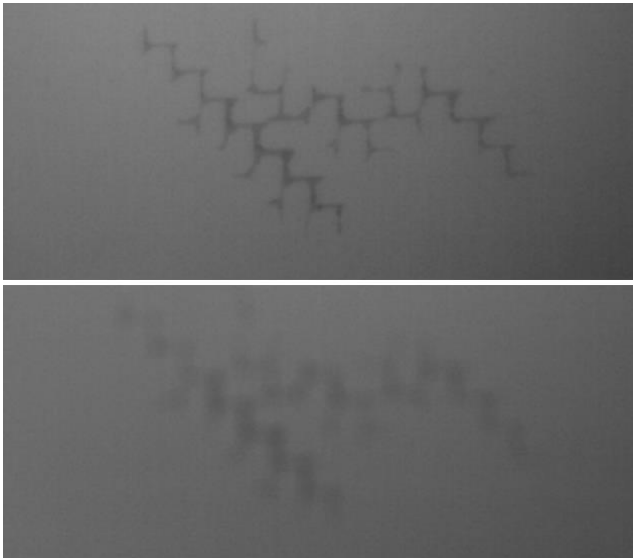
Figure 1. Comparison between a corrected IR image ( above ) and a defocused IR image ( below ).